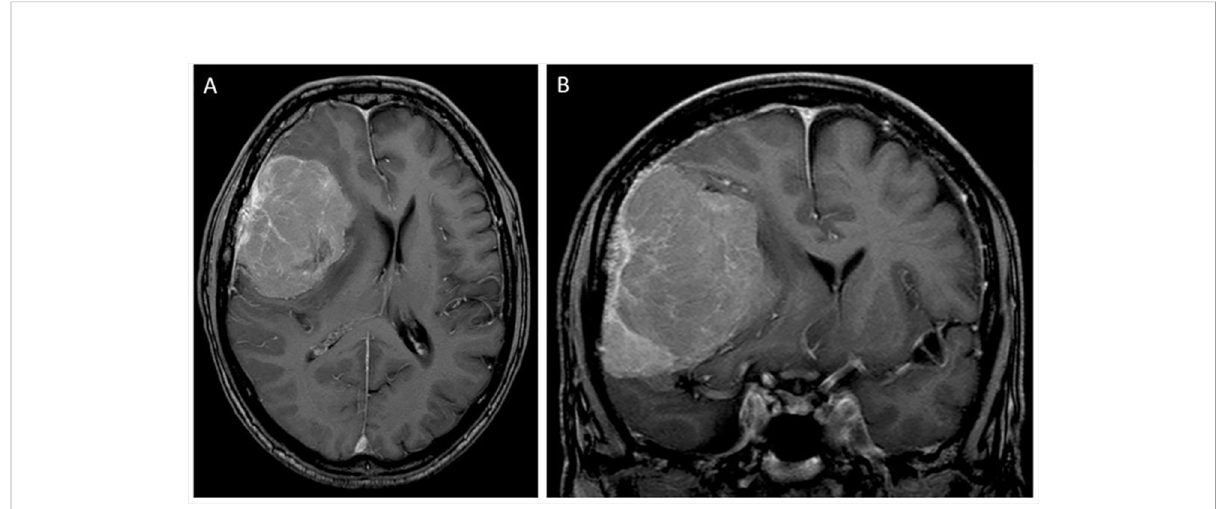
FIGURE 1 T1-contrast-enhanced MRI scan in axial (A) and coronal (B) sections at the initial diagnosis showing a large right frontal (approximately 5.5 cm × 7.0 cm) tumor with dural attachment, suggestive of a meningioma, with midline and brain